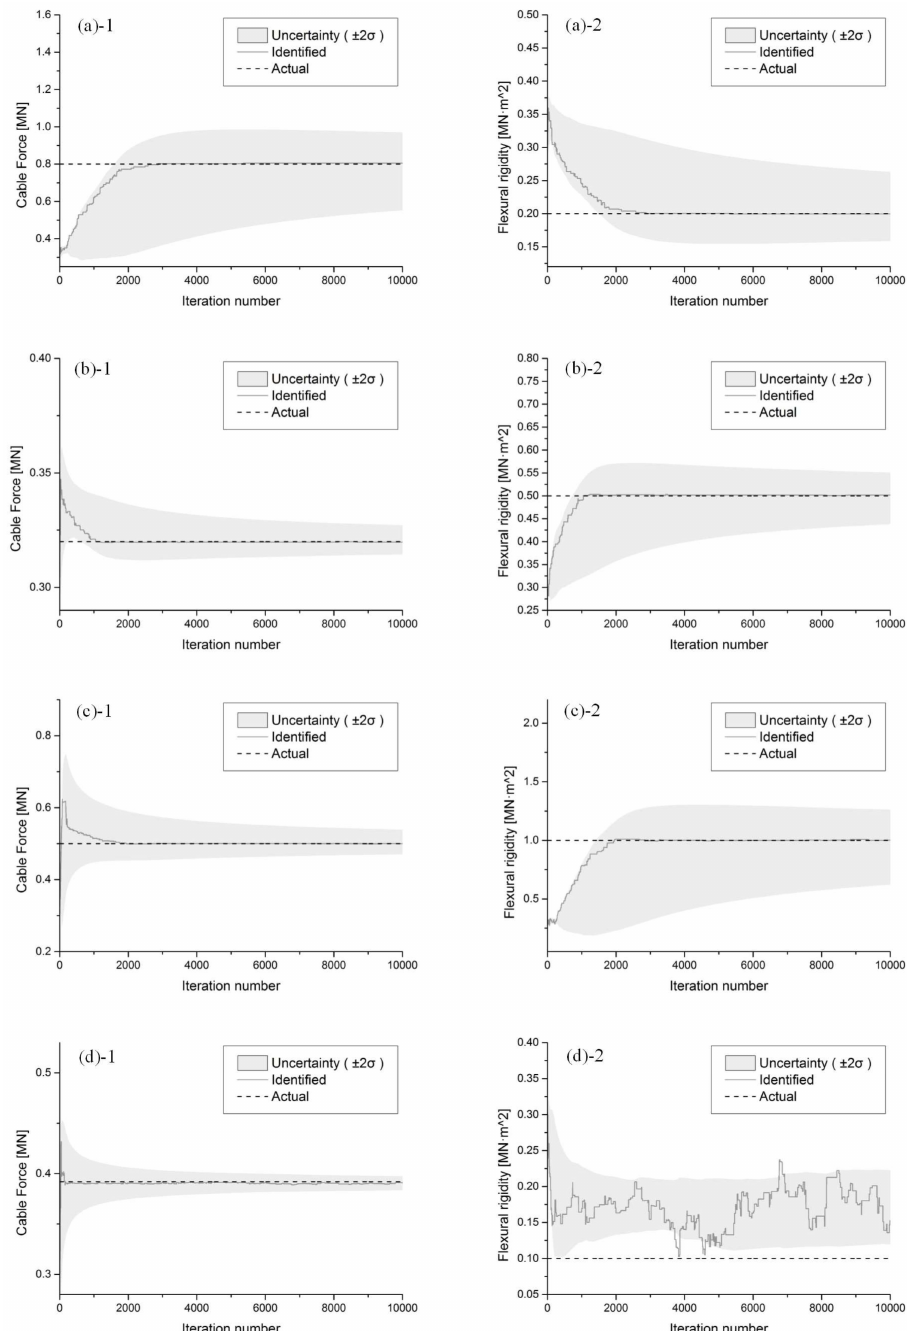
Figure 4. Convergence of the cable force and the flexural rigidity of ( a ) Cable 1, ( b ) Cable 2, ( c ) Cable 3, and ( d ) Cable